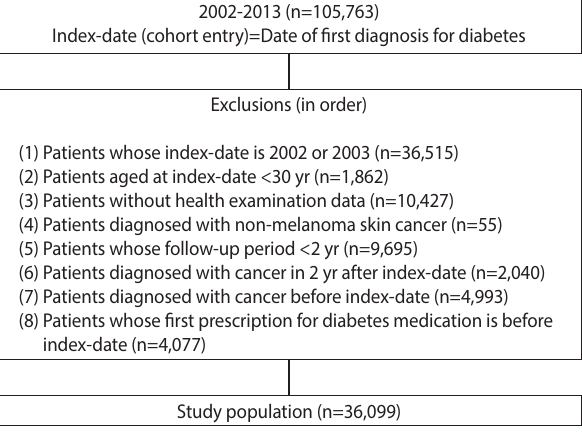
Figure 1. Flowchart of the sampling